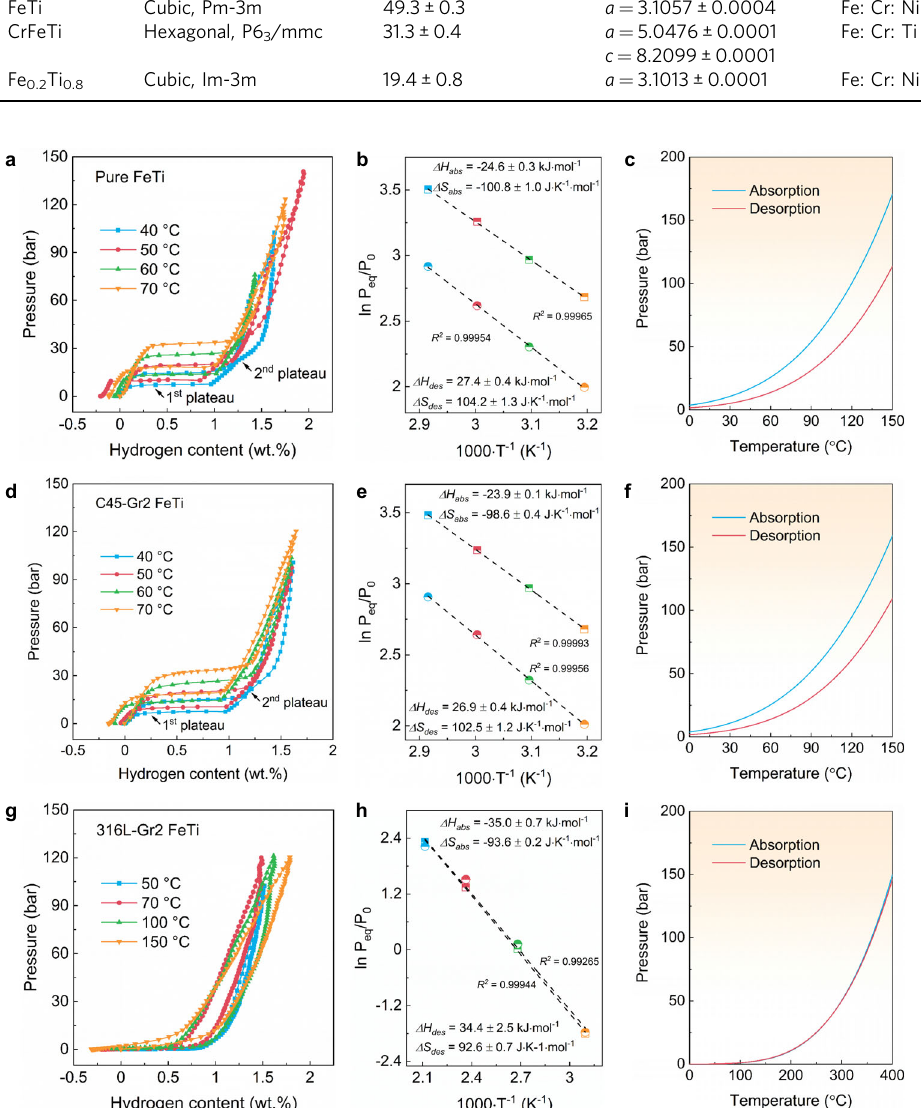
Fig. 3 Reversible hydrogen storage capacities of pure FeTi, C45-Gr2 FeTi, and 316L-Gr2 FeTi alloys. a PCI curves (at 40 °C, 50 C, 60 °C, and 70 °C), b van ’ t Hoff plots of hydrogenation/dehydrogenation, and c P-T diagram of pure FeTi. d PCI curves (at 40 °C, 50 C, 60 °C, and 70 °C), e van ’ t Hoff plots of hydrogenation/dehydrogenation, and f P-T diagram of C45-Gr2 FeTi. g PCI curves (at 50 °C, 70 C, 100 °C, and 150 °C), h van ’ t Hoff plots of hydrogenation/dehydrogenation, and i P-T diagram of 316L-Gr2 FeTi change, as shown in the pressure-temperature (P-T) phase diagram (Fig. 3c, f), re fl ecting the gap between absorption and desorption does not change signi fi cantly. Surprisingly, there is no hysteresis for the 316L-Gr2 FeTi, evidenced by the overlapped absorption and deso- rption curves in Fig. 3i. absorption plateau is higher than the desorption plateau, which is normally not desired for practical applications. By replacing pure Fe and Ti with C45 and Gr2 Ti, the hysteresis does not have a signi fi cant